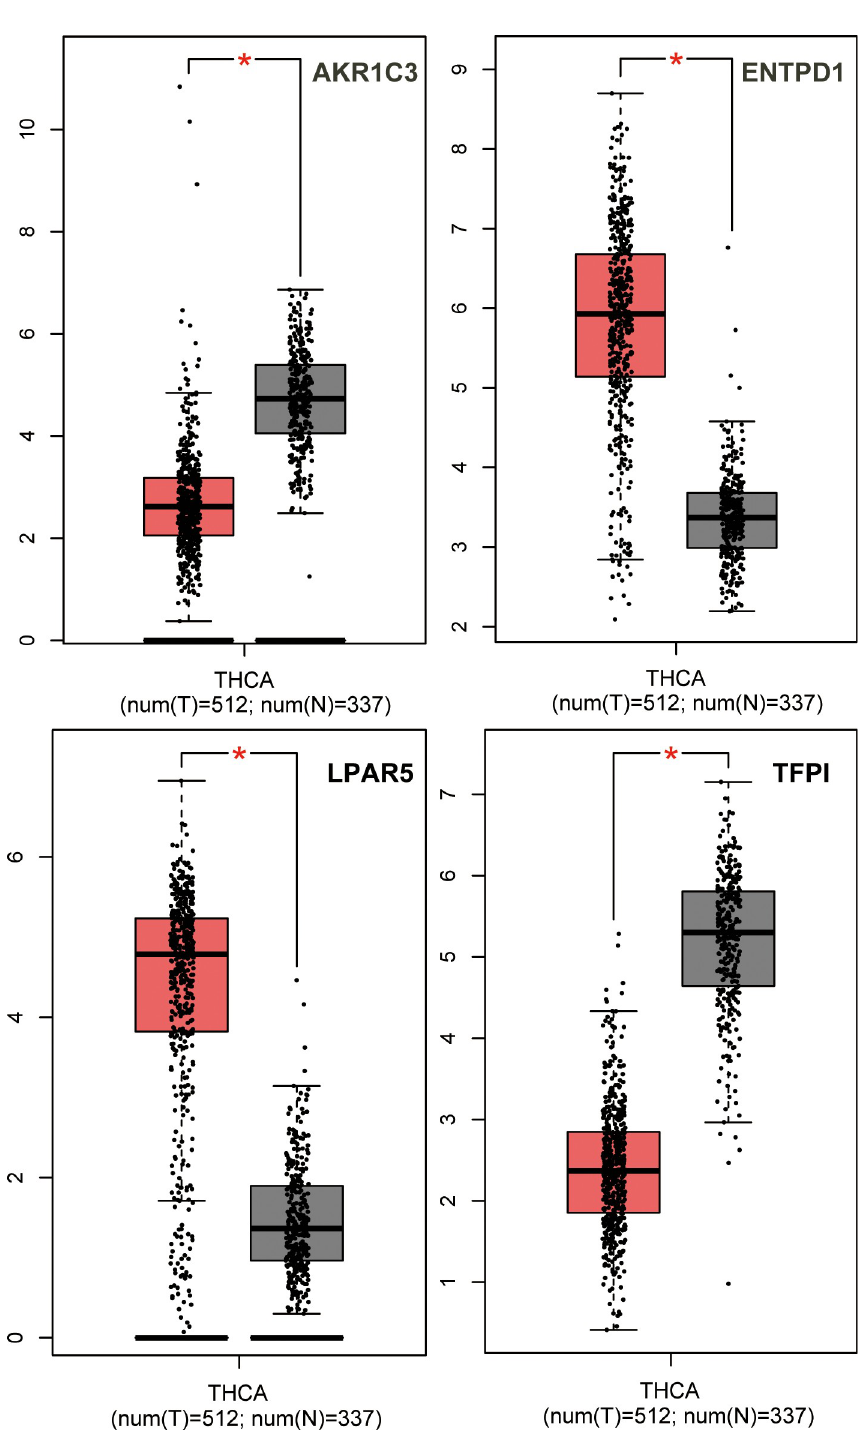
Fig 6. Analysis of hub gene expression levels with GEPIA analysis. The transcript expression comparison of four genes in normal (n = 59) and tumor (n = 505) tissues via GEPIA.